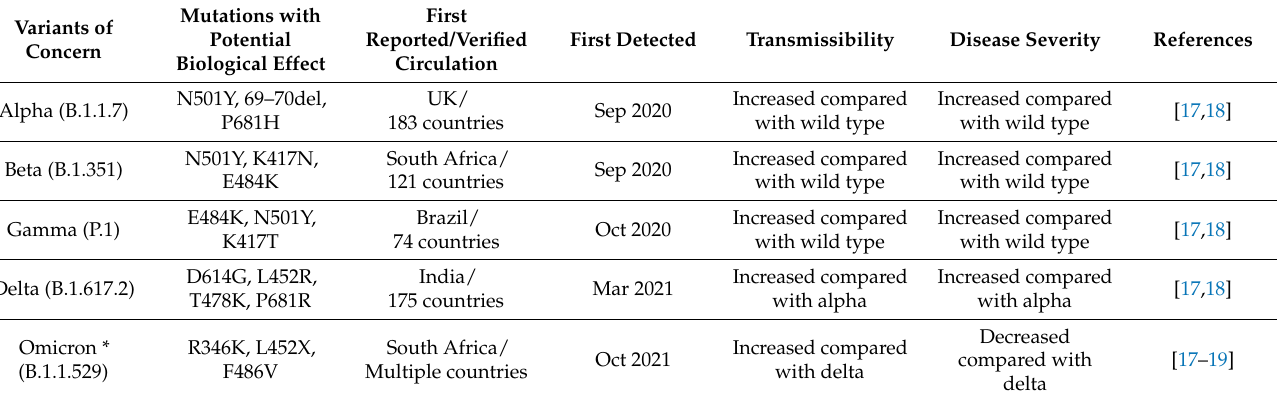
Table 1. Variants of concern of the SARS-CoV-2 virus circulating